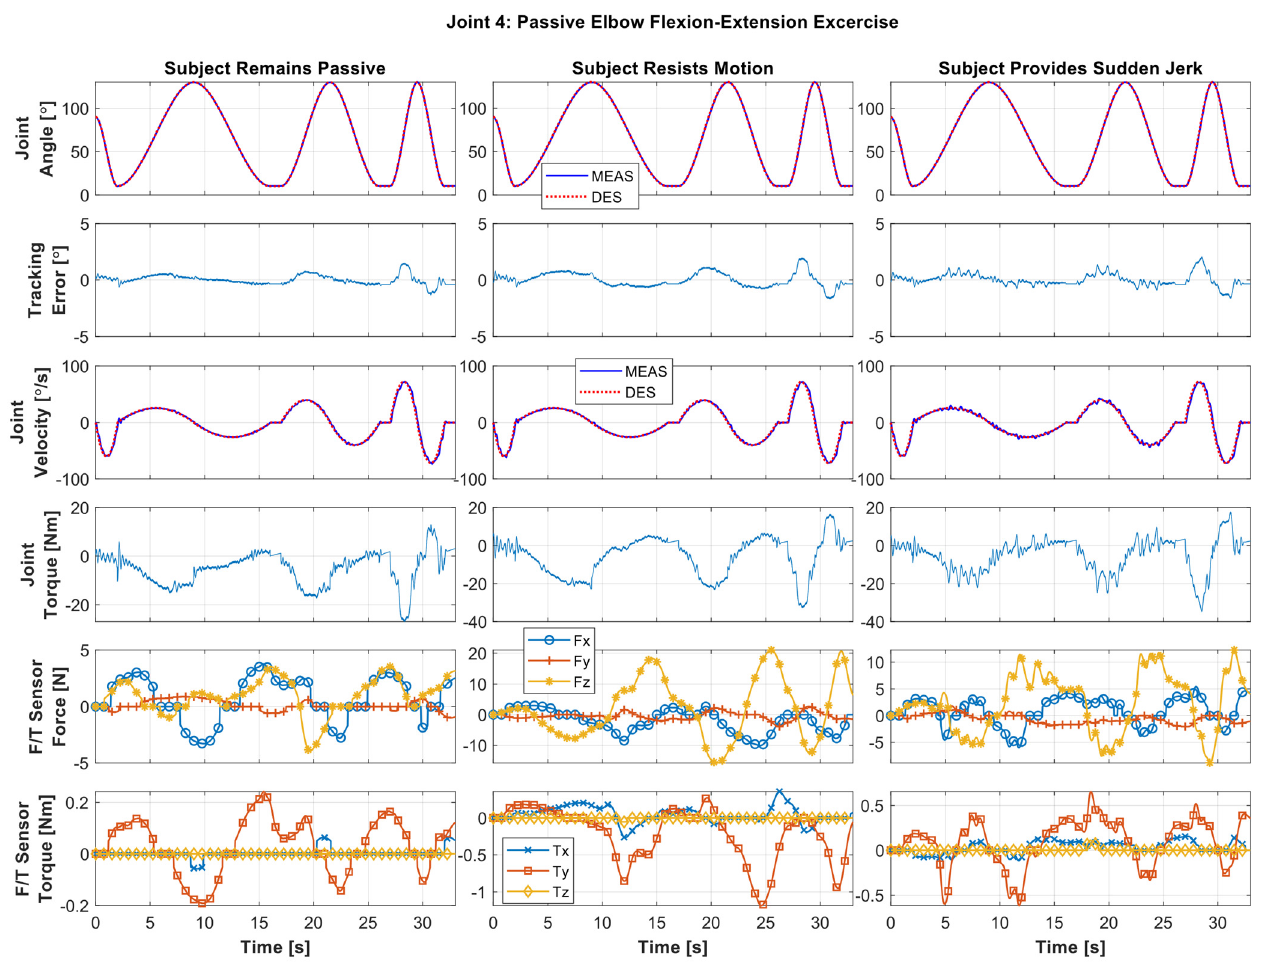
Figure 6. Passive elbow flexion (130°)/extension (10°) exercise for Subject A, where the subject exerts no force during the exercise ( left column), resists the motion ( middle column), and provides sudden jerk motion throughout the exercise ( right column).